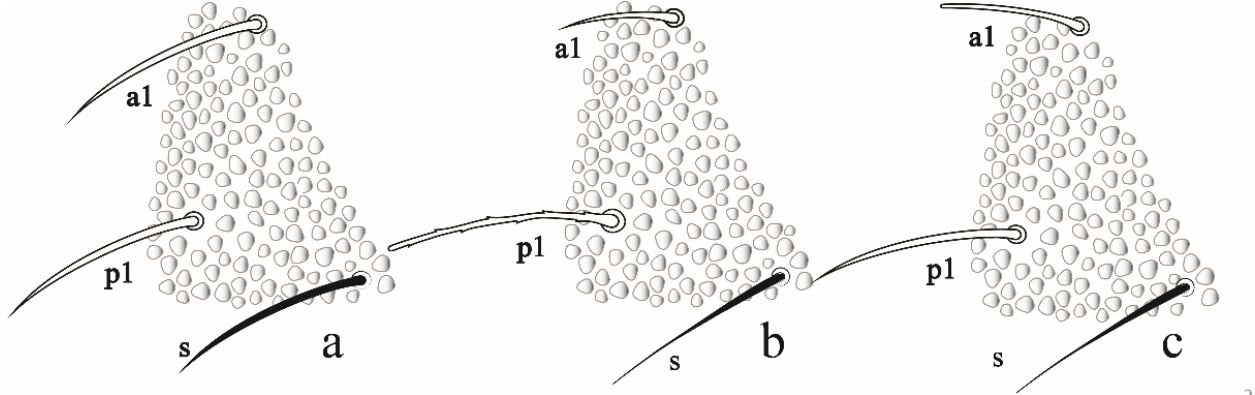
Figure 10. Comparasion between a1, p1 and S-chaetae of abdominal segment V in: ( a ) Friesea rochedoensis sp. nov. ( b ) Friesea noronhaensis sp. nov. ( c ) Friesea cubensis (modified from [6]).